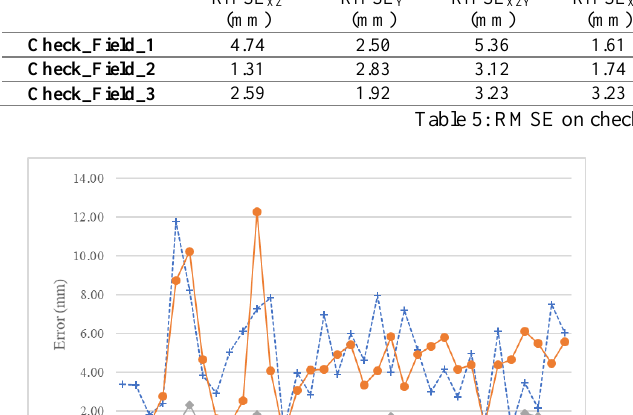
Figure 7: Check-point error on Check_Field_1.